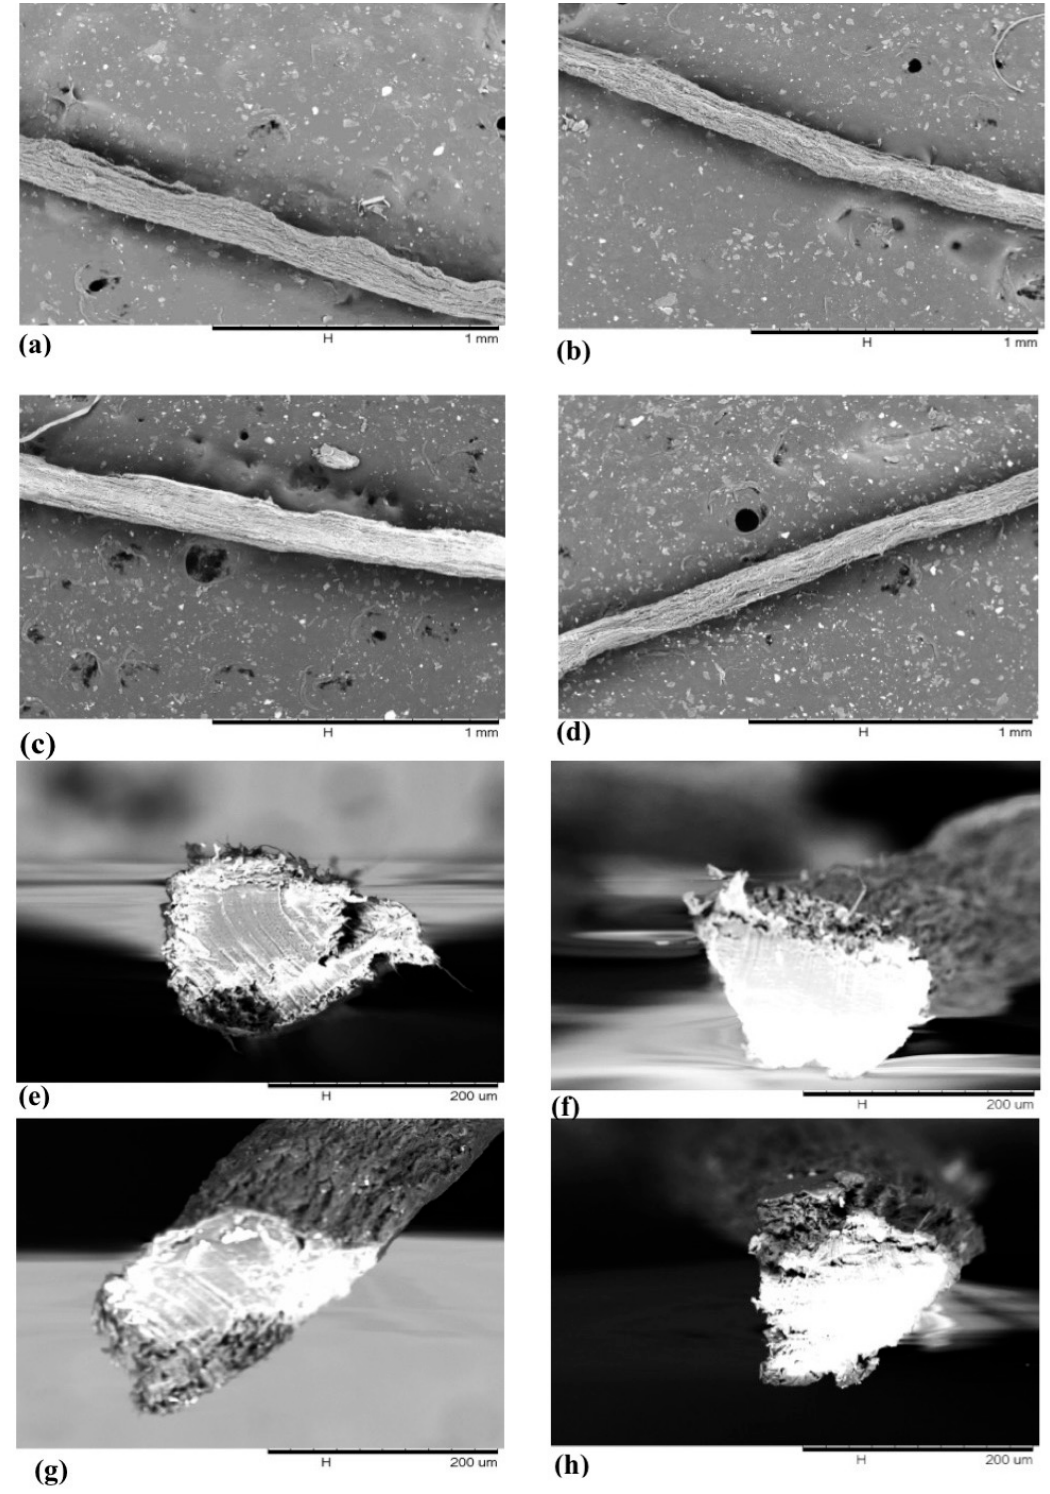
Figure 5. SEM micrographs from the surface of filaments-dried under different temperatures: ( a ) CNF 100G air-dried; ( b ) CNF 100G 210 °C; ( c ) CNF 100G 320 °C; ( d ) CNF 100G 430 °C. SEM micrograph of cross-sections of filaments dried at different temperatures: ( e ) CNF 100G air-dried; ( f ) CNF 100G 210 °C; ( g ) CNF 100G 320 °C; ( h ) CNF 100G 430 °C.